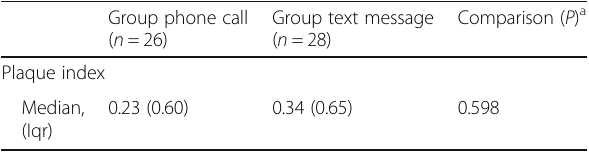
Table 4 Plaque index change recorded at the first orthodontic checkup 1 month after professional cleaning and instruction in the telephone call and text message